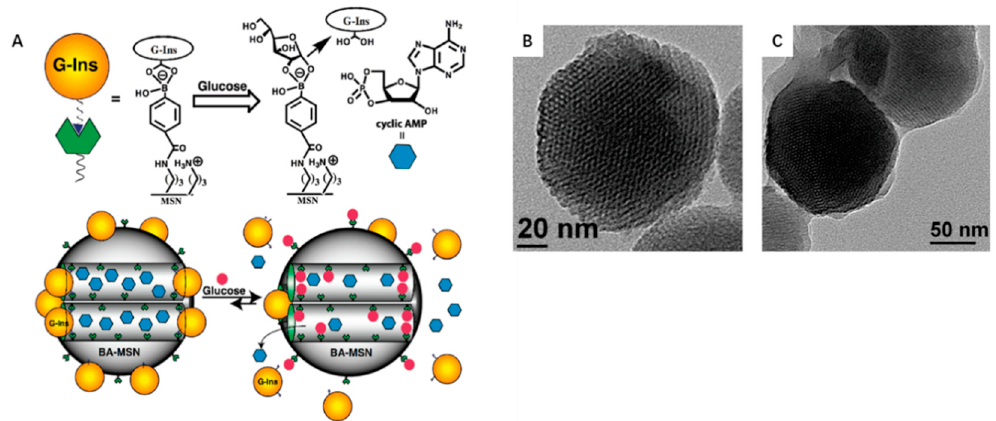
Figure 3. ( A ) Schematic illustration of a double drugs co-delivery system for controlled release of bioactive G-Ins and cAMP. cAMP is confined into the MSN pore; G-Ins is modified on the surface as a pore cap. ( B ) Transmission electron micrograph (TEM) of boronic acid-functionalized MSN. (C)TEM of FITC-G-Ins-capped MSN [39].